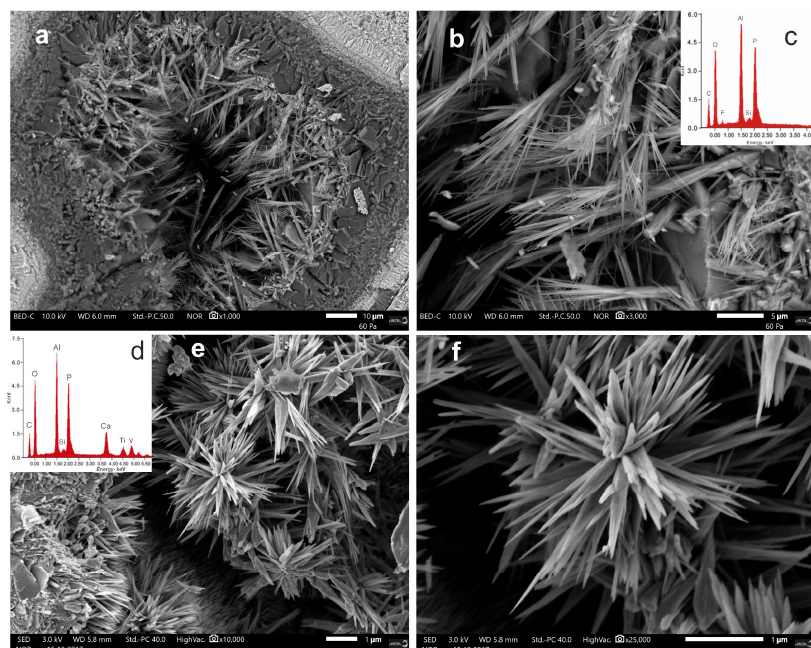
Figure 5. Wavellite and crandallite microcrystals: ( a ) wavellite crystals in vug; ( b ) needles form broom-like aggregates; ( c ) EDX spectrum indicates the major constituents of wavellite crystals (Al, P, F, O); ( d ) EDX spectrum shows the major constituents of crandallite crystals (Al, P, Ca, O with some trace elements); ( e ) crandallite crystals sprays; ( f ) radial needles of trigonal crandallite crystals.